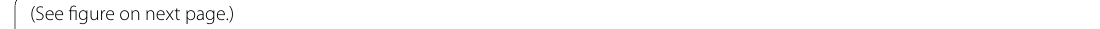
figure on next Fig. 1 Circular map of the Streptomyces diastaticus CS1801 genome. a Chromosome; b plasmid. From the outside to the inside: the first circle represents the COG database-annotated genes, with the color corresponding to the COG-annotated letter; the second circle represents RNA; the third circle is the GC content (the peak level reflects the GC amount), with the outer circle representing the sense chain and the inner circle representing the antisense chain; and the innermost circle reflects the asymmetry of the GC